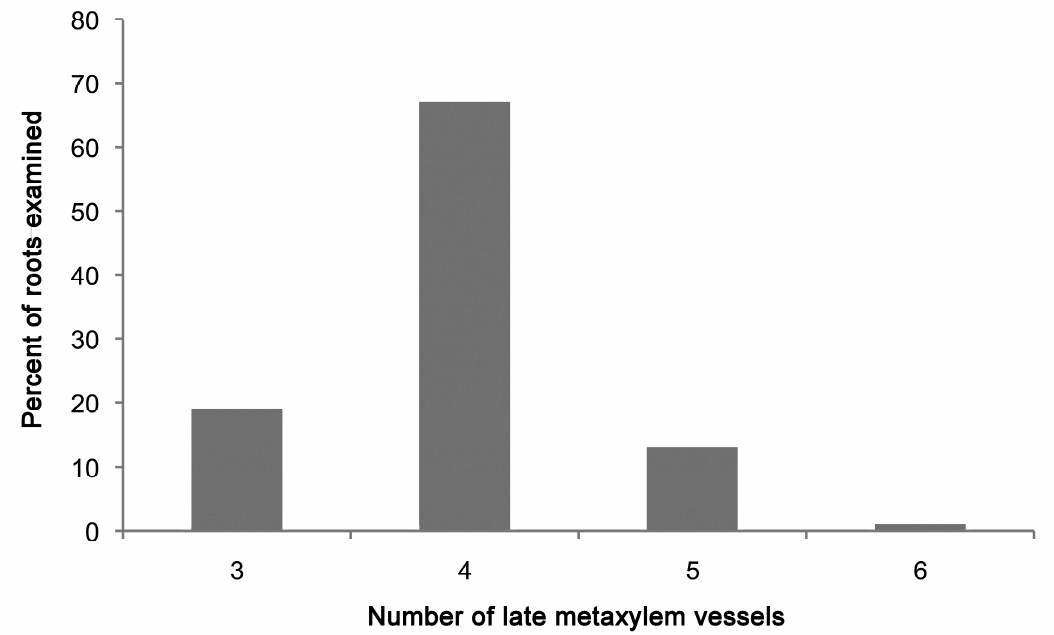
Plants 2019 , 8 , x FOR PEER REVIEW Figure 2. Distribution of numbers of late metaxylem vessels per primary root among 227 teosinte seedlings.